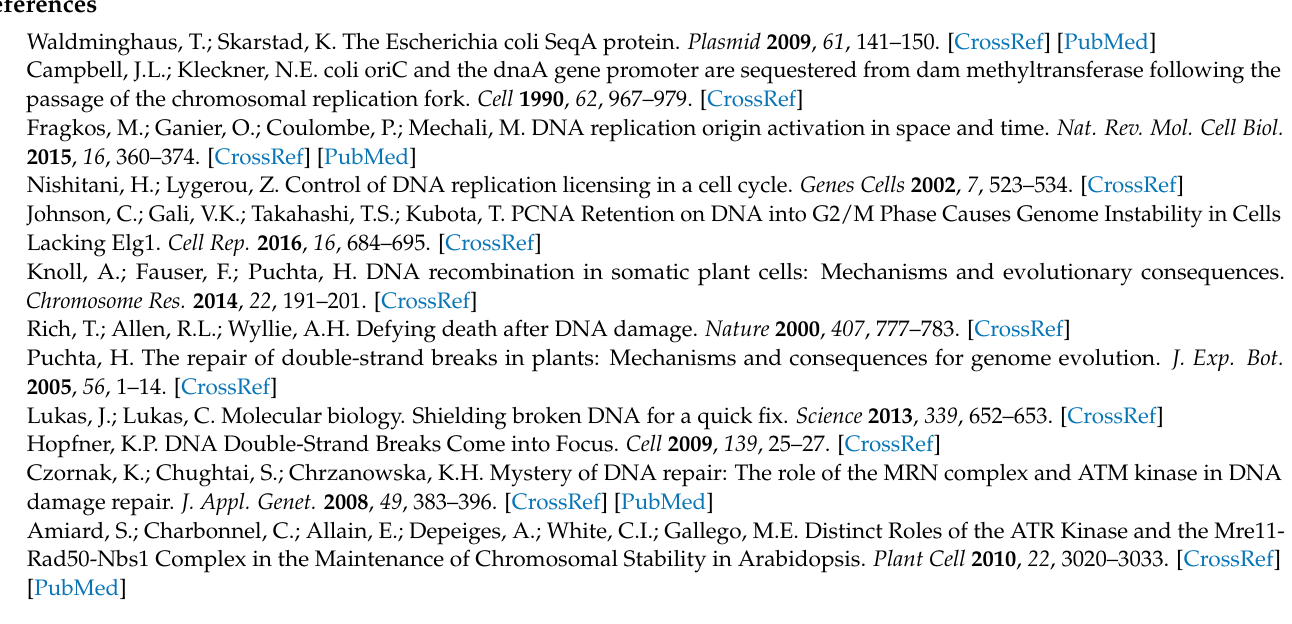
Figure S2: Phylogenetic analysis of OsMre11 and other 11 homologs. Figure S3: Expression patterns of OsRad50 and OsNbs1 in rice. Figure S4: Relative expression level of OsMre11 responded to Aphidicolin and MMC in 10DAG seedlings. Figure S5: The three-dimensional structure of Mre11, Rad50, and Nbs1 in various species. Figure S6: BiFC assay shows the interaction relationships between OsMre11, OsRad50, and Os-Nbs1 in tobacco leaf epidermis cells. Figure S7: